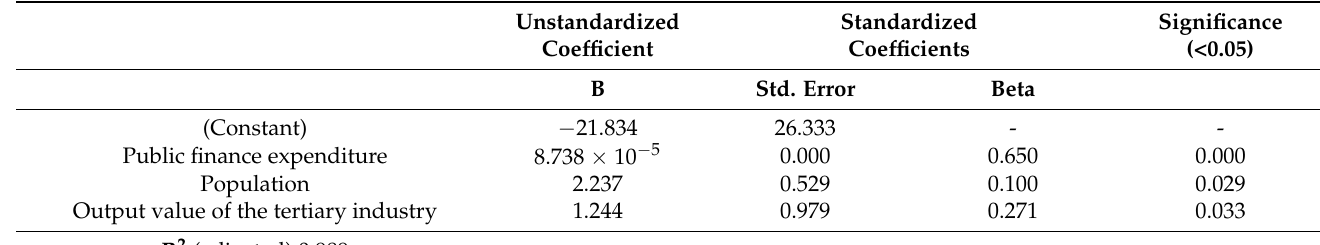
Table 5. Summary of the regression model.